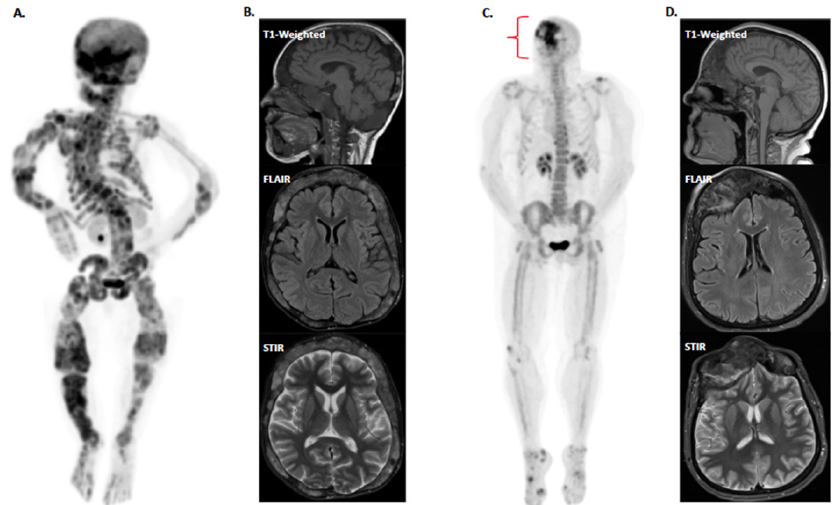
Figure 1. Whole-body 18 F-NaF PET/CT and non-contrast craniofacial MRI for Patient 1 at age 23 ( A , B ) and Patient 2 at age 53 ( C , D ). ( A ) There is diffuse radioactive uptake in the axial and appendicular skeleton with pronounced focus in the craniofacial regions indicating polyostotic FD. ( B ) Craniofacial regions with diffuse FD lesions. Skull-based lesions are highlighted. ( C ) There is pronounced 18 F-NaF uptake in the craniofacial region with limited uptake in the rest of the body. ( D ) Extensive FD affecting the nasal bones and distorting the structure of the sinus cavity. 18 F-NaF PET = 18 F-sodium fluoride positron emission tomography, CT = computed tomography, MRI = magnetic resonance imaging, FLAIR = fluid-attenuated inversion recovery, STIR = short tau inversion recovery.